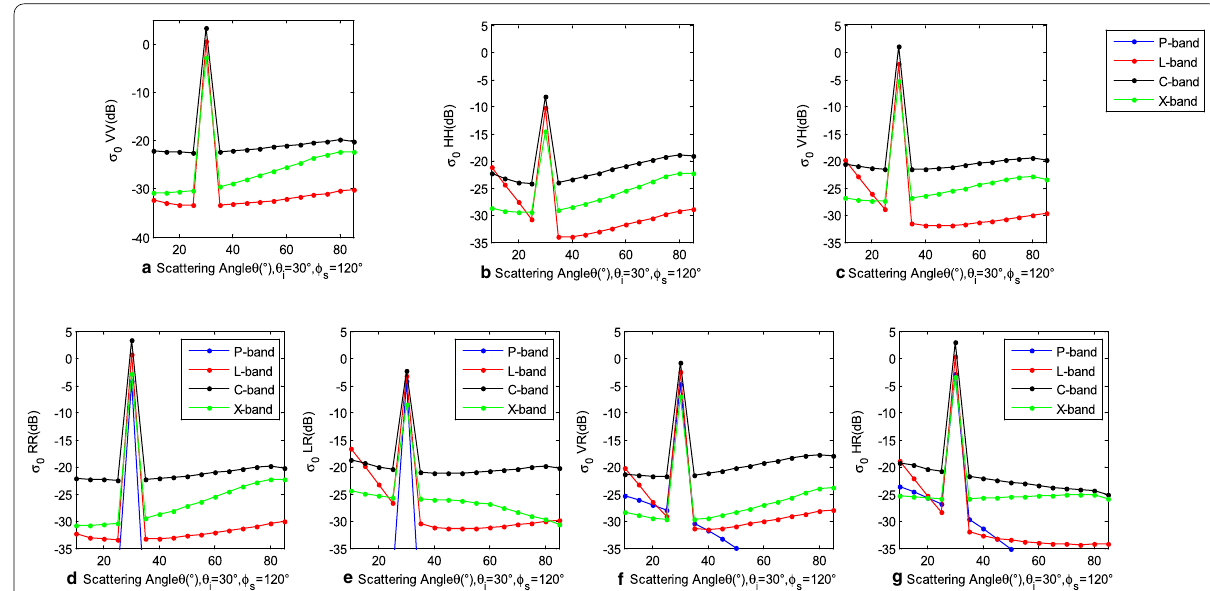
Fig. 10 Canopy scattering cross section versus scattering angle from aspen for L-,C-, and X-bands at θ i = 30 o , ϕ s = 120 o